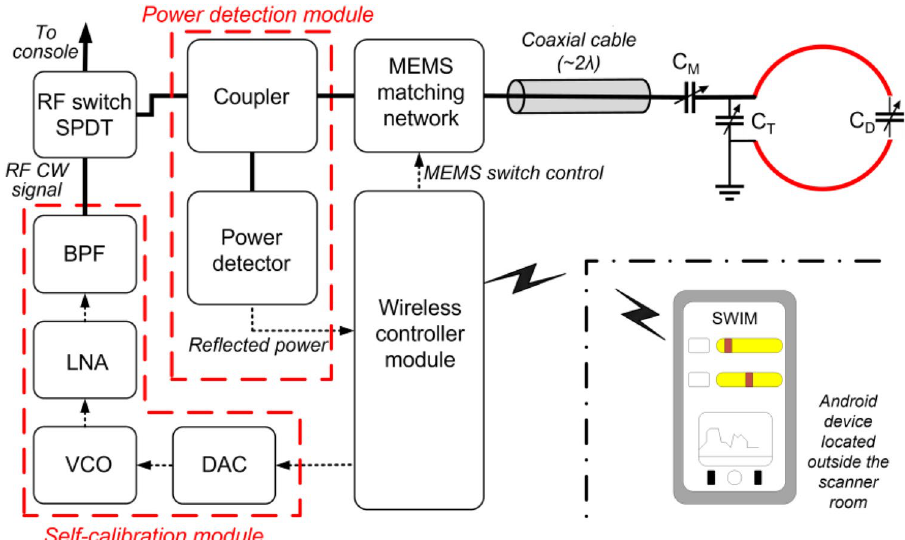
Figure 1. System level block diagram of the proposed SWIM